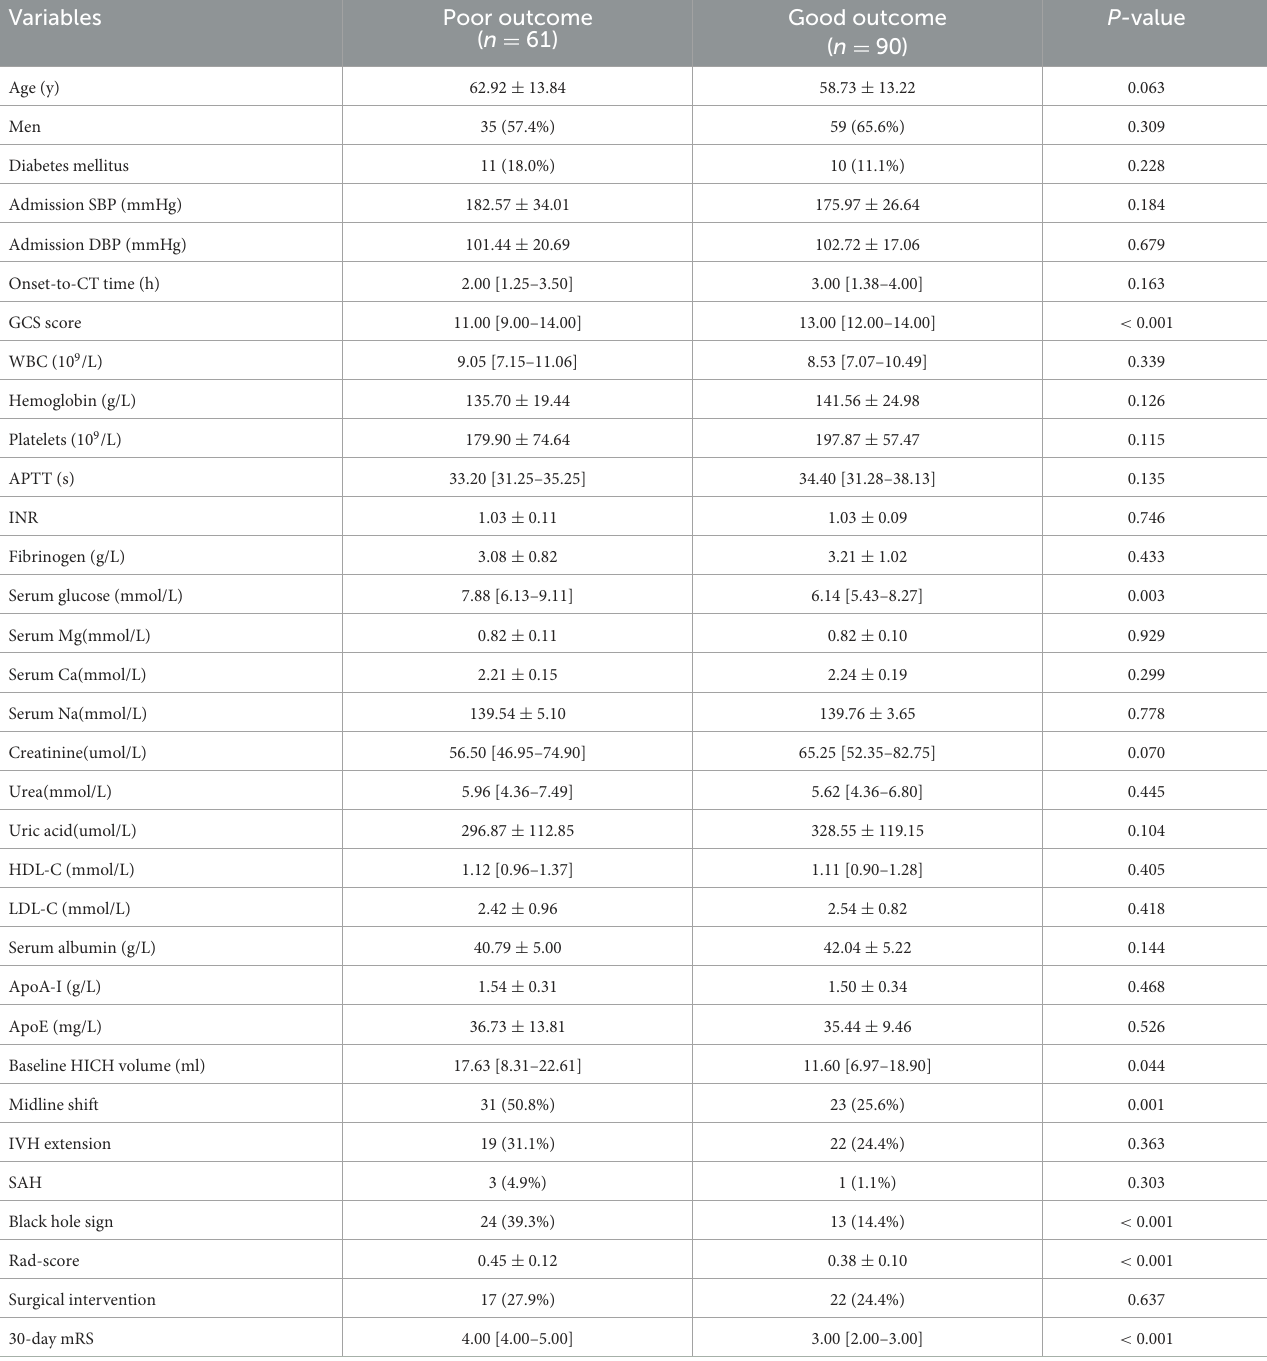
TABLE 1 Comparison of baseline characteristics between patients with good outcomes and those with poor outcomes in the training cohort.